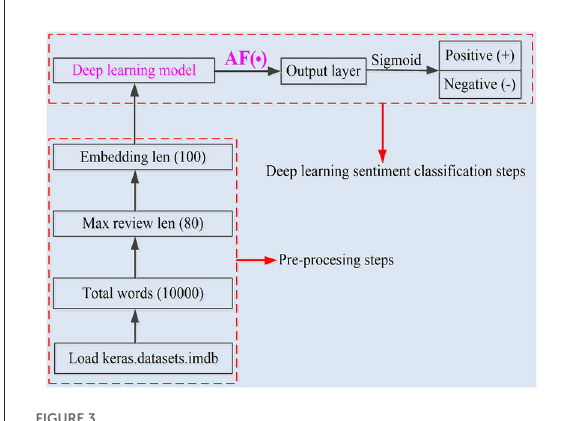
FIGURE3 Sentiment classification diagram.